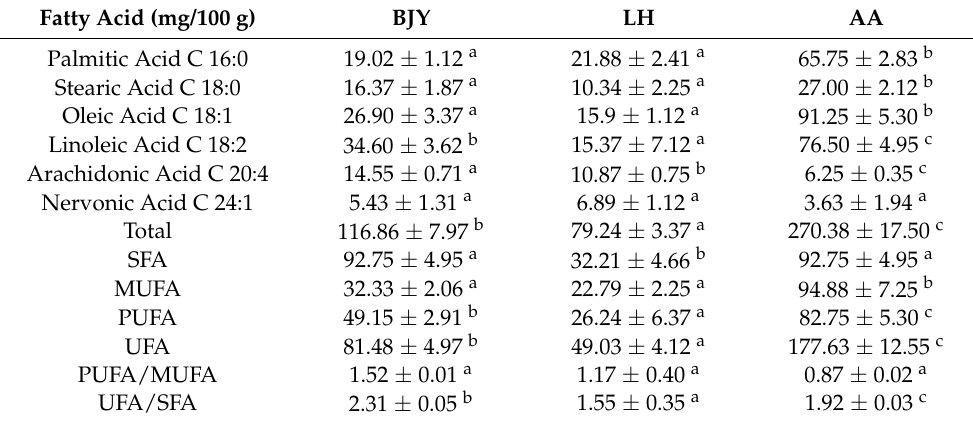
Table 4. Fatty acid contents of different types of chicken breast (mg/100